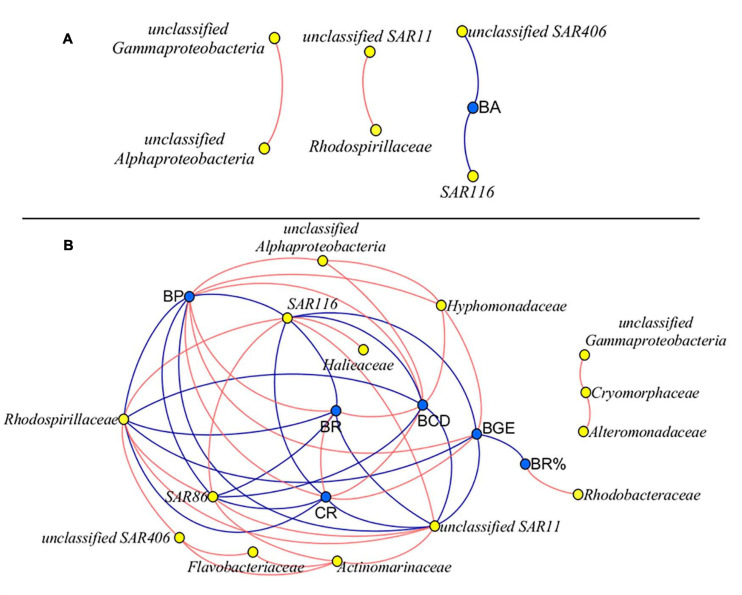
Network analysis between bacterial metabolic activity and community composition at M8 (A) and K11 (B), respectively. Data on bacterial species on Day 0 were not included. Blue nodes: bacterial metabolic parameters, yellow nodes: bacterial species. Red lines: positive correlation, blue lines: negative correlation. R > 0.7 and R < −0.7, p < 0.05. For samples of HC at K11 on Day 4, n = 2. For other treatments, n = 3.